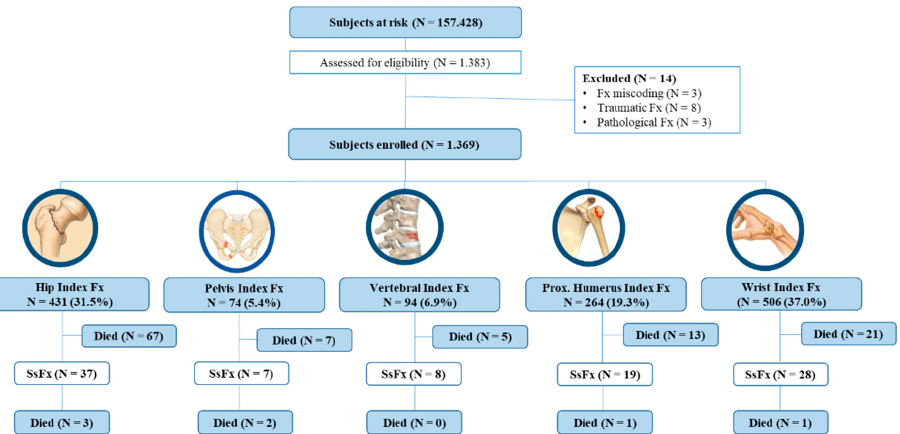
Figure 1. Flow diagram of study participants based on the Strobe statement. A total of 1383 subjects were assessed for eligibility, among a study population of 157,428 inhabitants. Fracture miscoding or traumatic or pathological causes of fractures were the causes for the exclusion of 14 subjects. Subjects were enrolled from January 2014 to December 2014 and followed up until December 2016. Mean duration of follow-up was 2.3 years for all subjects, 2.2 years in males and 2.3 in females. The most frequent types of index fracture were wrist (N = 506, 37.0%) and hip (N = 431, 31.5%), followed closely by proximal humerus (N = 264, 19.3%). Overall, 99 subjects registered a subsequent fracture, with 120 events of death occurring throughout follow-up. Fx: fracture. SsFx: subsequent fracture.